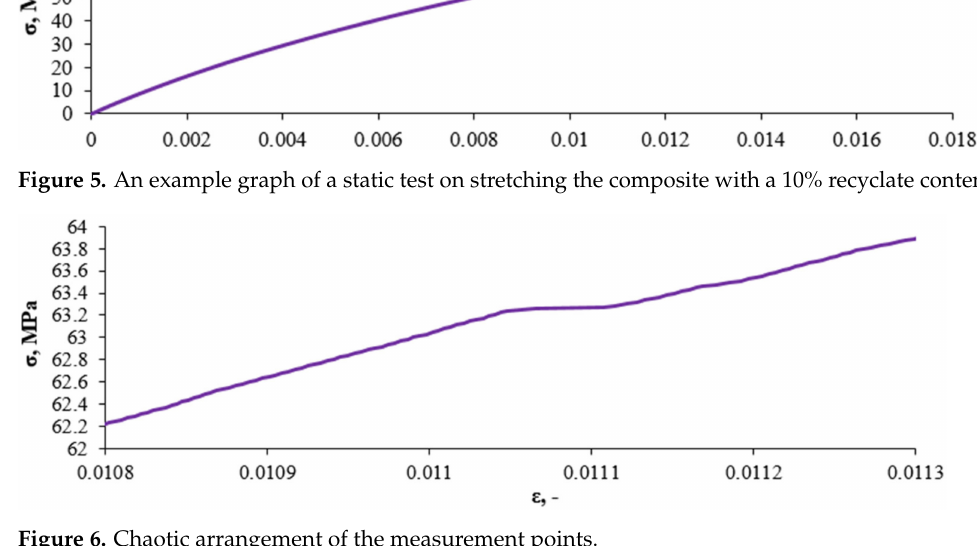
Figure 6. Chaotic arrangement of the measurement